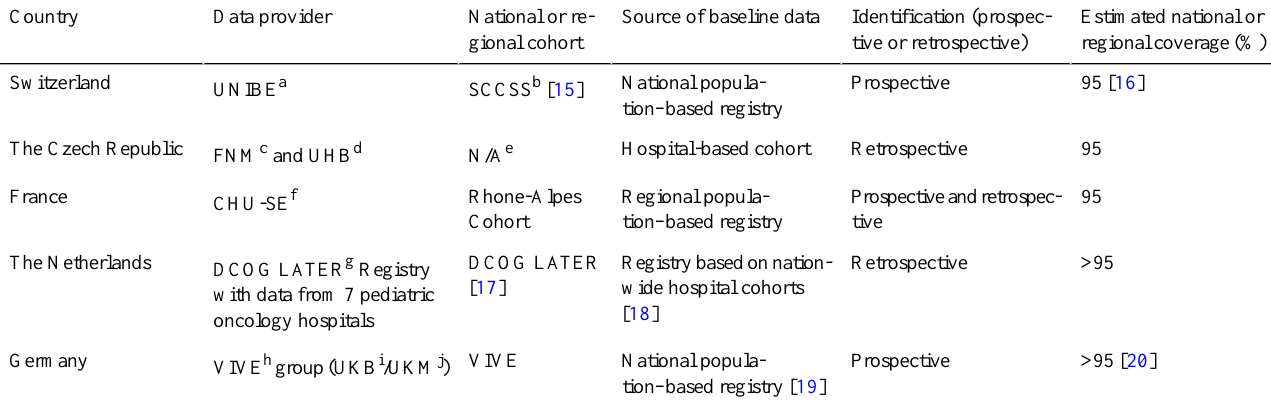
Table 1. Sources of eligible survivors for the PanCareLIFE health-related quality of life study.